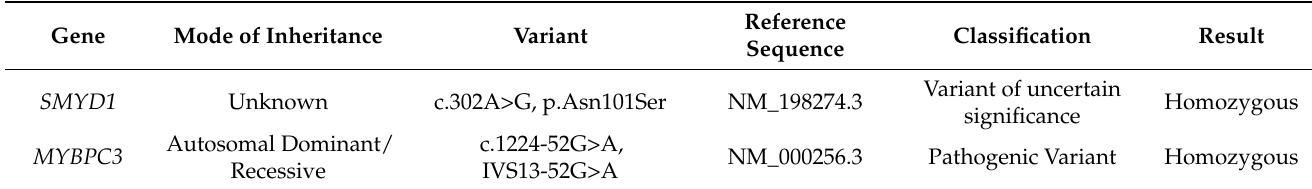
Table 2. Gene variants identified by whole exome sequencing in